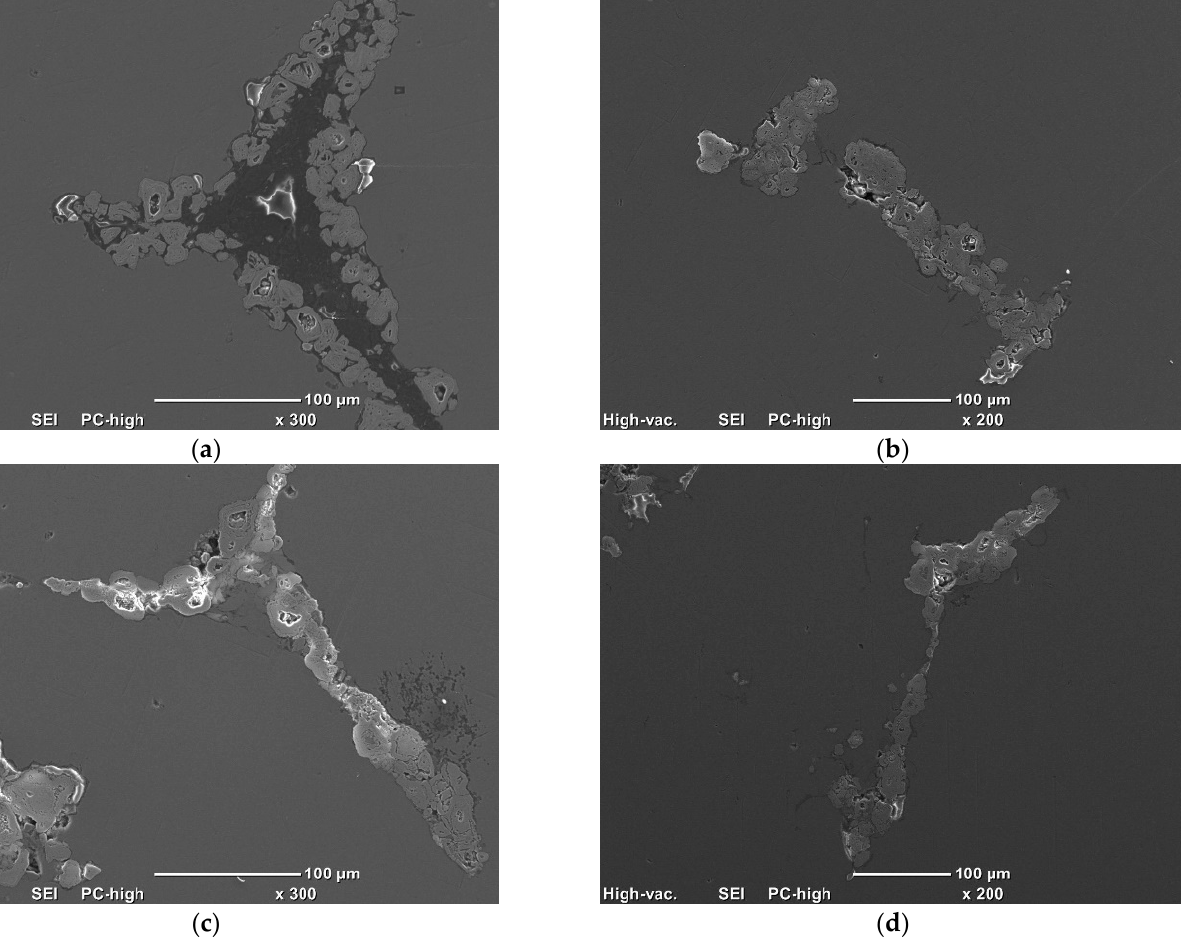
Figure 10. The microstructures of composites after heat treatment at 600 °C at varying times: ( a ) 2 h; ( b ) 8 h; ( c ) 24 h; ( d ) 72 h (SEM).